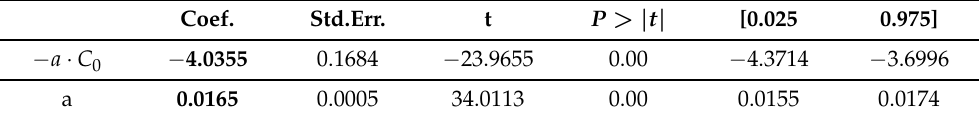
Table 6. Estimation of constant absorption parameters with measured data from 1950 to 2020. Coef.